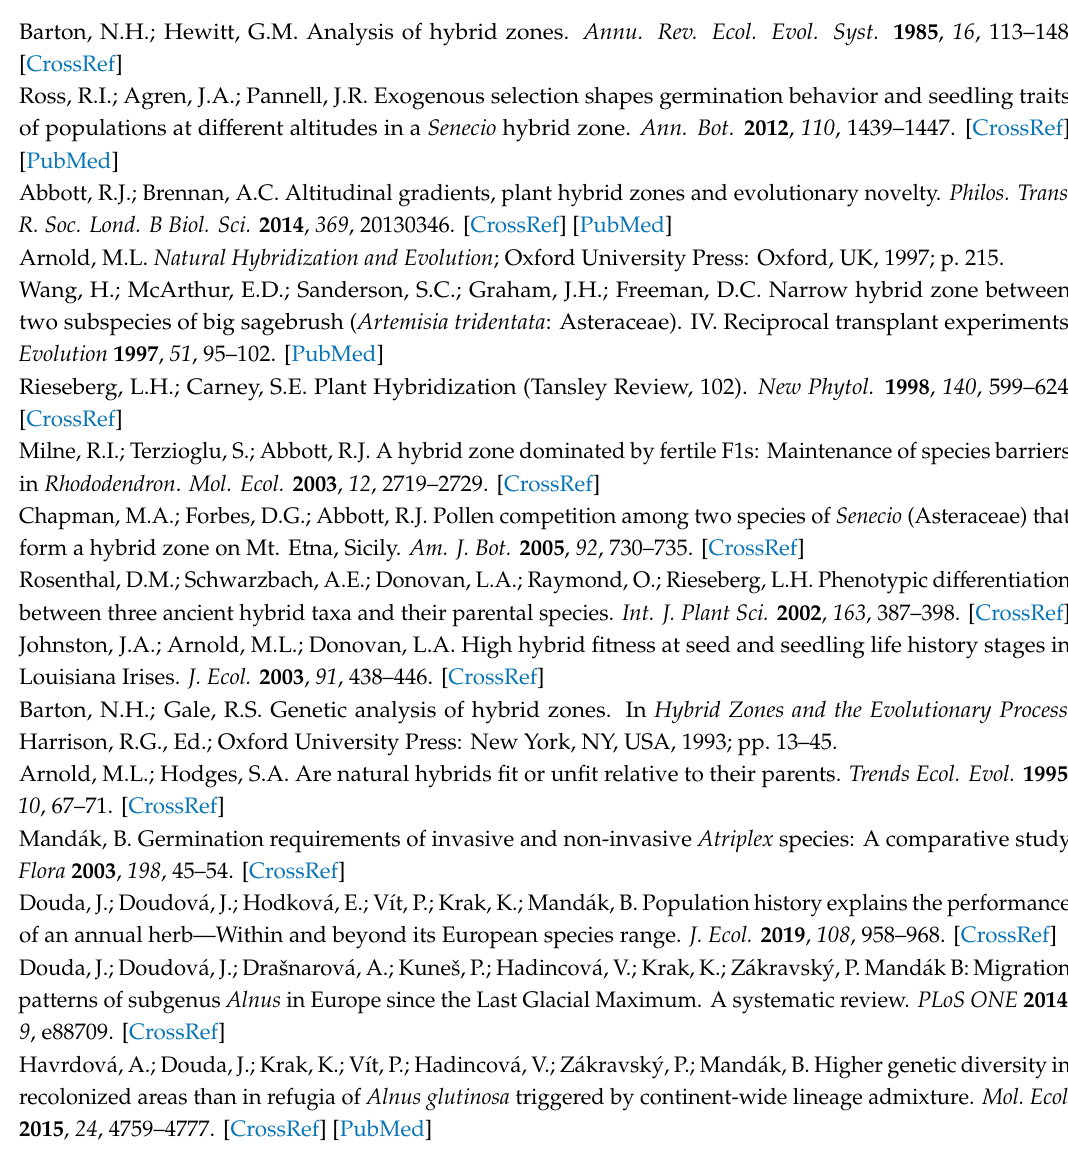
Table S1: Locality details of Alnus accessions sampled; Table S2: Di ff erences in germination between Alnus